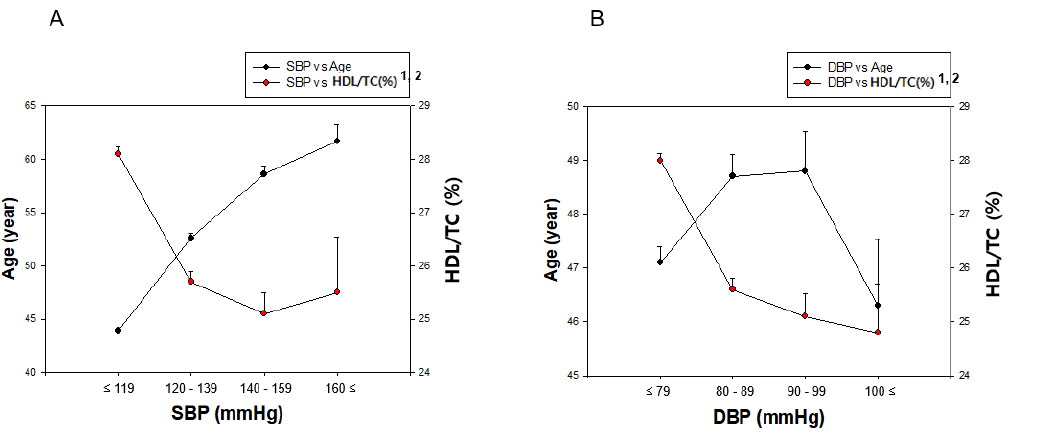
Figure 5. Correlation of age and HDL-C / TC (%) depends on SBP ( A ) and DBP ( B ) in total population. Negative association was found between age and HDL-C, depending on SBP or DBP, by J–T test. Pearson’s correlation analysis was carried out between age, HDL-C / TC (%), and SBP ( A ) and DBP ( B ). Panel A showed a negative correlation (r = − 0.188, p < 0.001) between SBP and HDL-C / TC (%); panel B showed a negative correlation (r = − 0.198, p < 0.001) between DBP and HDL-C / TC